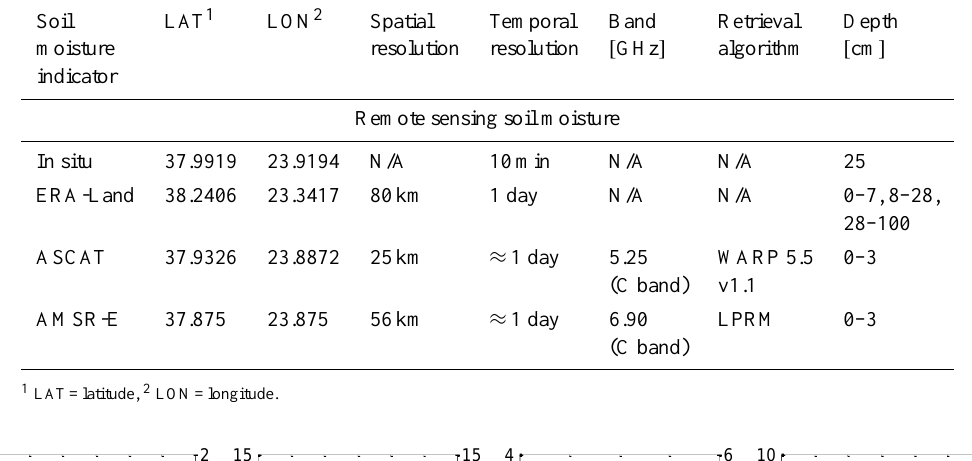
Table 2. Soil moisture indicators used in this study.